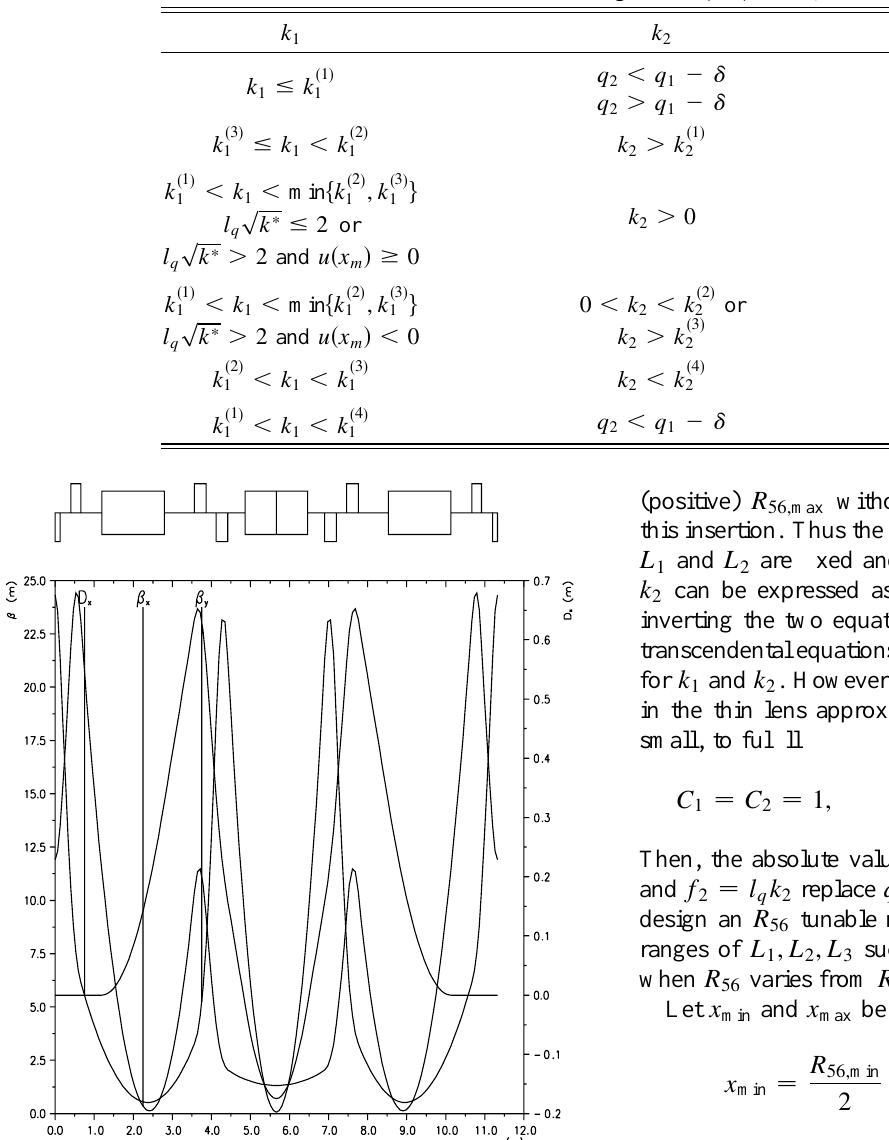
FIG. 2. 90 ± isochronous arc for the CLIC rf power